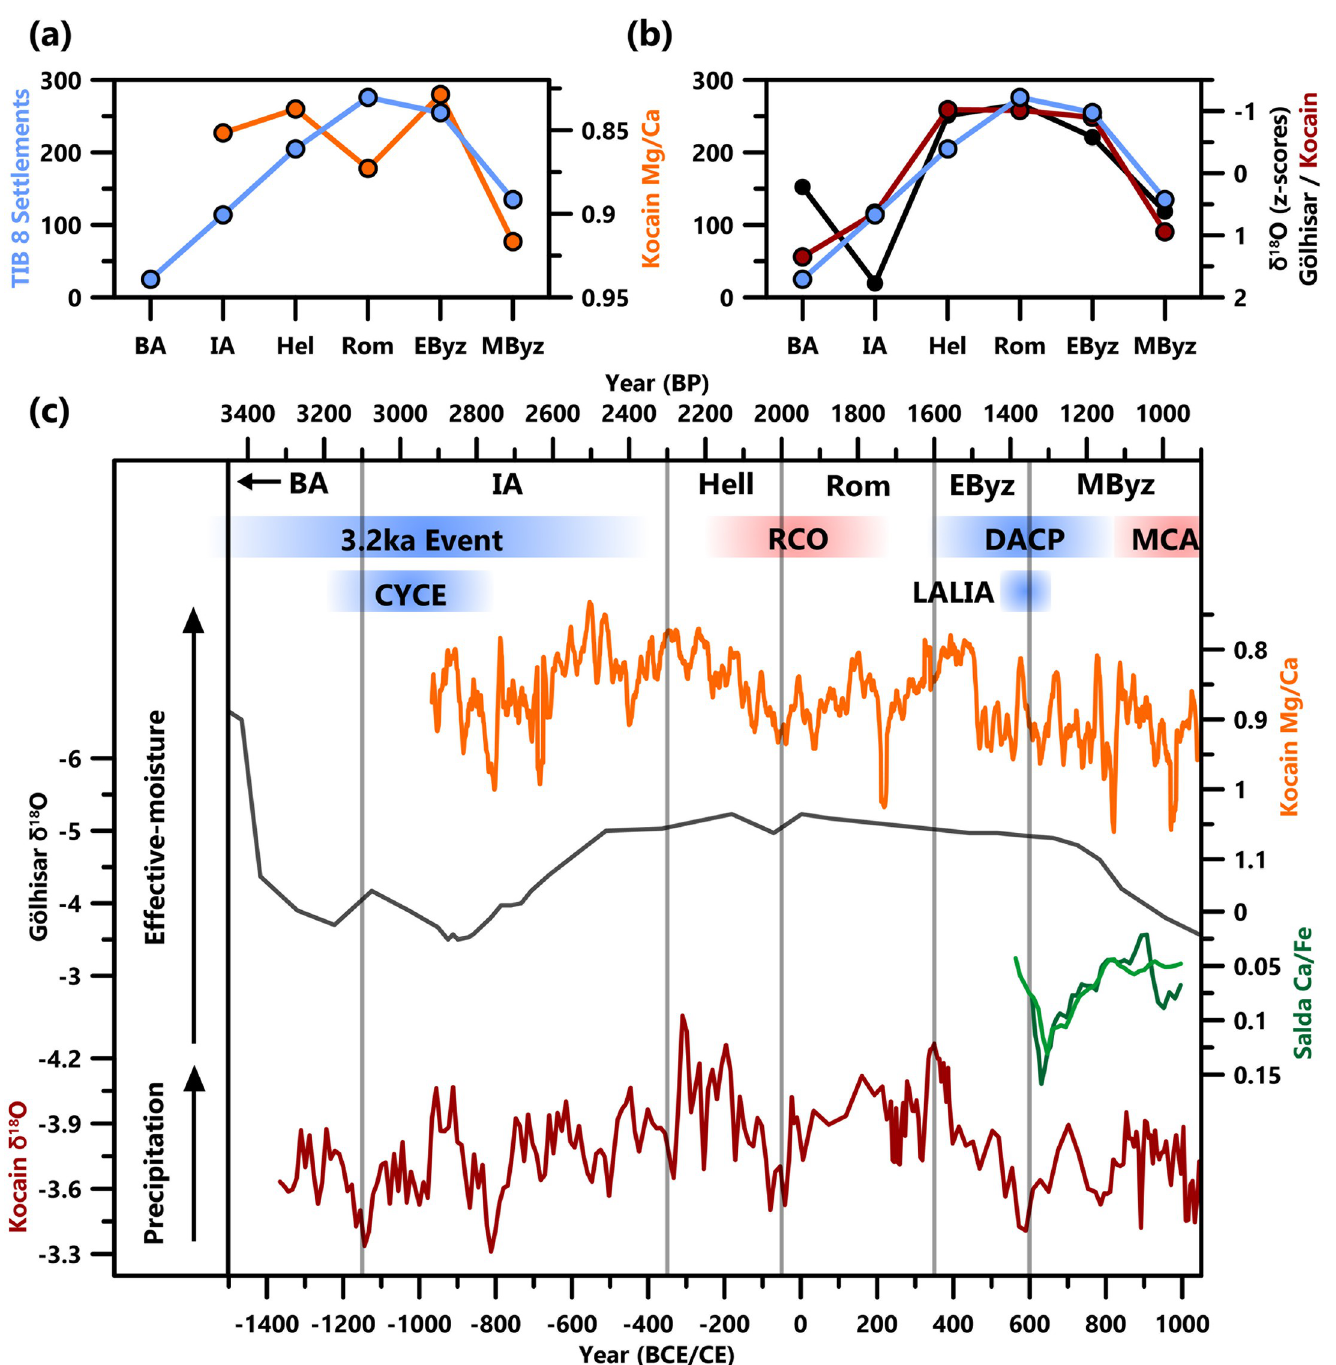
Fig 5. Regional paleoclimate data. Produced settlement data are compared to period averages of ( a ) Ko-1 Mg/Ca and ( b ) δ 18 O from Go¨lhisar and Ko-1. ( c ) Full paleoclimate data (metadata of records in S2 Table) with warm/cold intervals highlighted: Crisis Years Cold Event (CYCE), Roman Climatic Optimum (RCO), Dark Ages Cold Period (DACP), Late Antique Little Ice Age (LALIA) and Medieval Climate Anomaly (MCA). Kocain Mg/Ca (15-year averages), Go¨lhisar δ 18 O, and Salda Ca/Fe, are largely indicative of effective moisture; Kocain δ 18 O reflects precipitation, with secondary influences from seasonality and temperature [21–23].